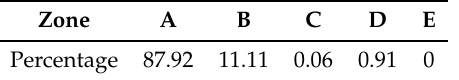
Table 7. Percentage of data points in grid zones.